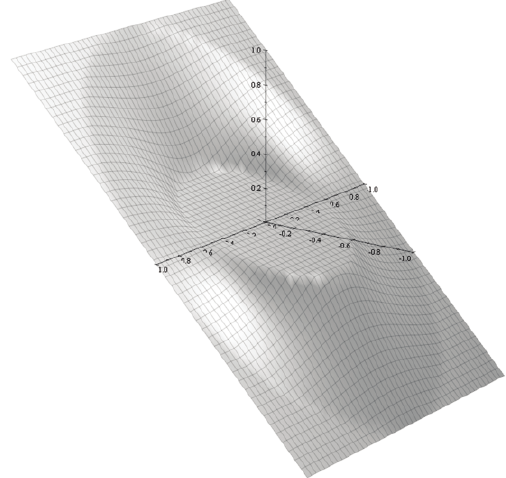
Figure 2: The solution of (cid:3) 3.26 (cid:4) for the case when the conductivity of the disk B is k (cid:2) 5.